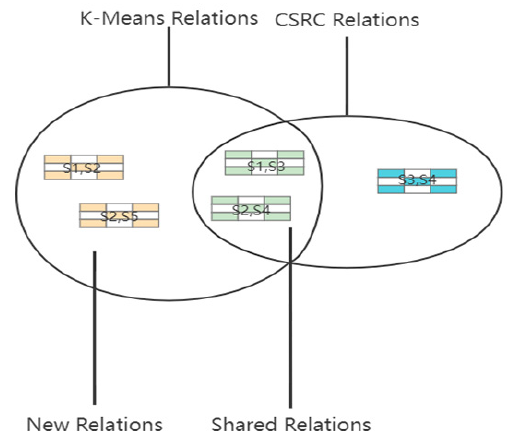
Figure 3. Four kinds of sets for stock relations.